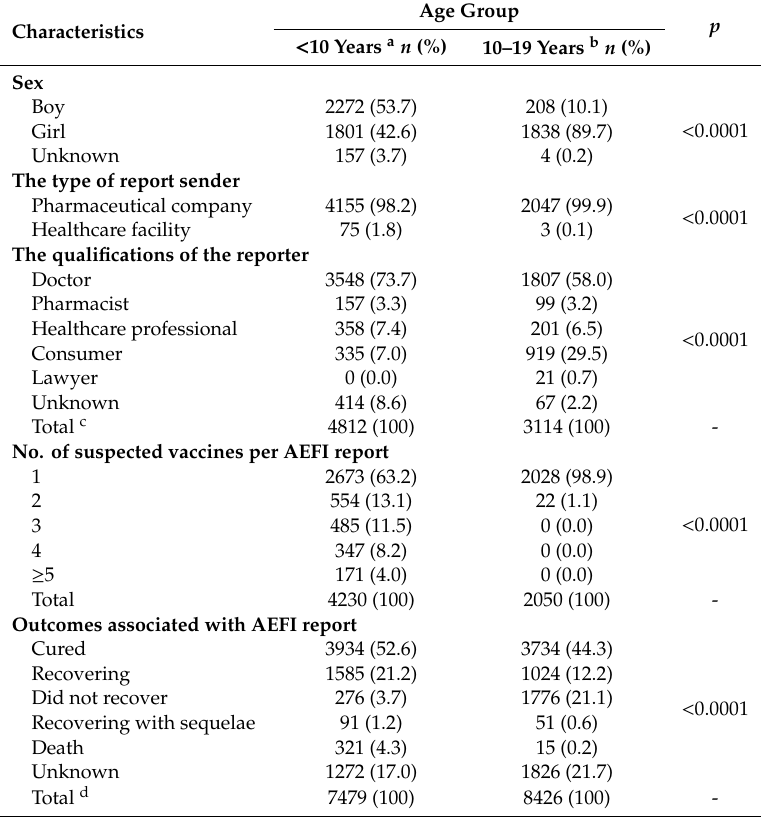
Table 1. Characteristics of AEFI reports according to age group.